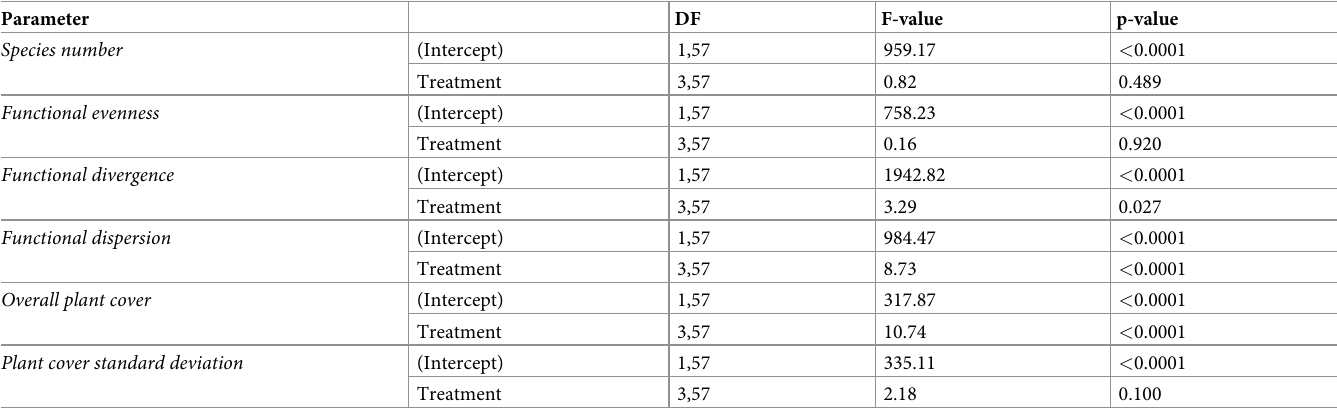
Table 1. Results of plant diversity indices.